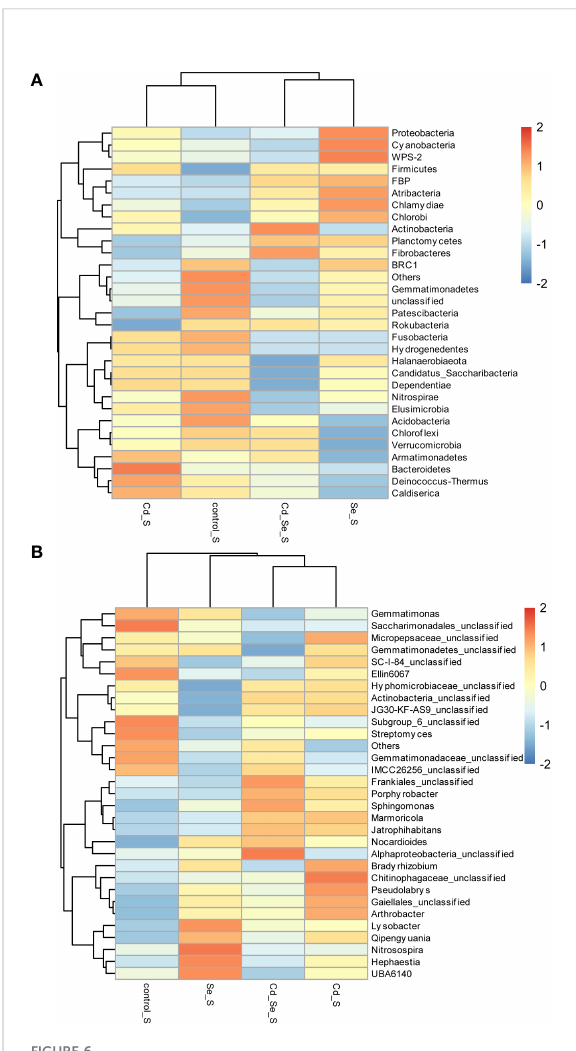
FIGURE 6 Effects of root exposure to Se (1.2 mg/kg) on non-rhizosphere soil species abundance in perilla under Cd stress (10 mg/kg). (A) Phylum level; (B) Genus